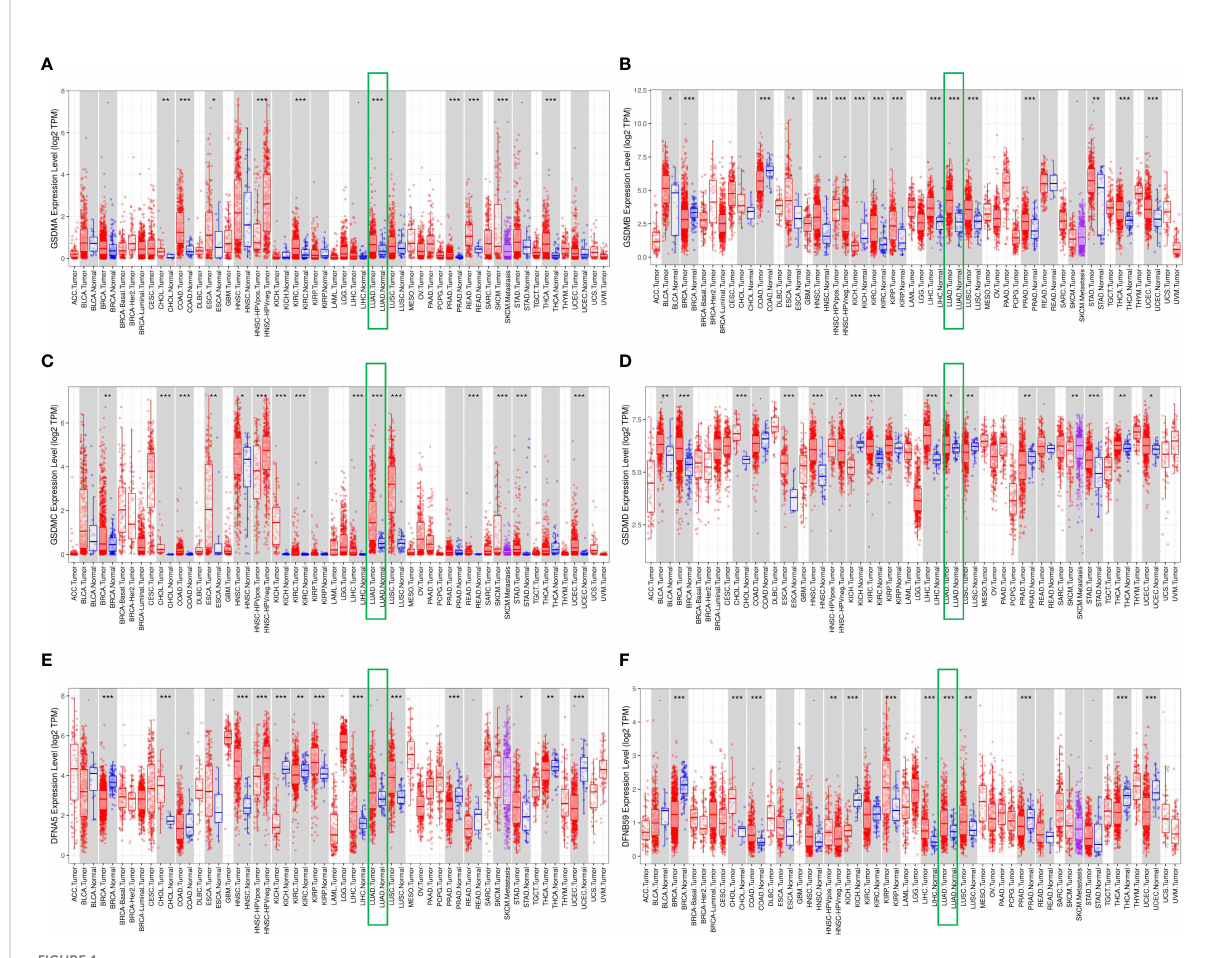
FIGURE 1 Differential expression of GSDMs between tumor and adjacent normal tissues. The expression of (A) GSDMA, (B) GSDMB, (C) GSDMC, (D) GSDMD, (E) GSDME, and (F) PJVK in different tumors and normal tissues based on the Timer database. * means p<0.05, ** means p<0.005, and *** means